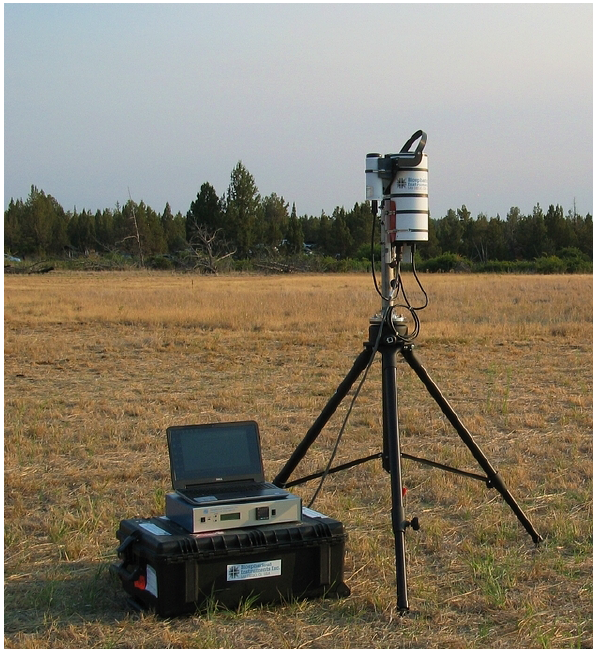
Figure 2. Setup of the GUVis-3511 radiometer at Smith Rock State Park. The radiometer (white cylinder), BioSHADE assembly, and BioGPS are mounted on a tripod. Shown next to the instrument is the laptop for recording the data, the instrument’s control unit, and a black case containing the power source.